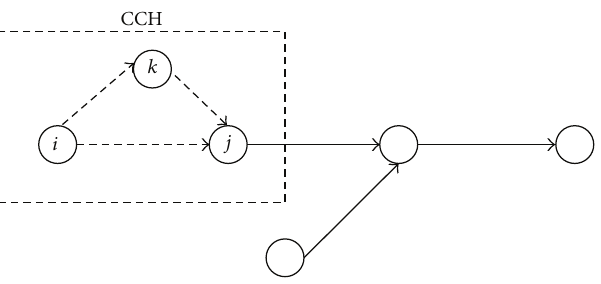
Figure 1: Multihop routing cooperative communication